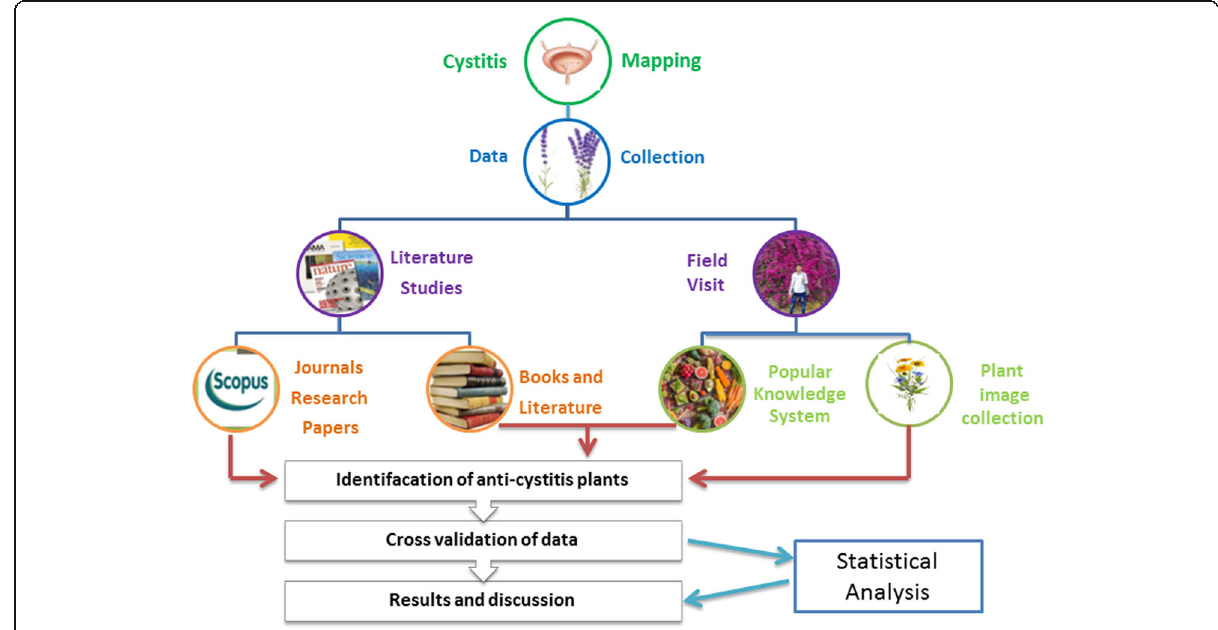
Fig. 2 Schematic flowchart for the identification of anticystitis